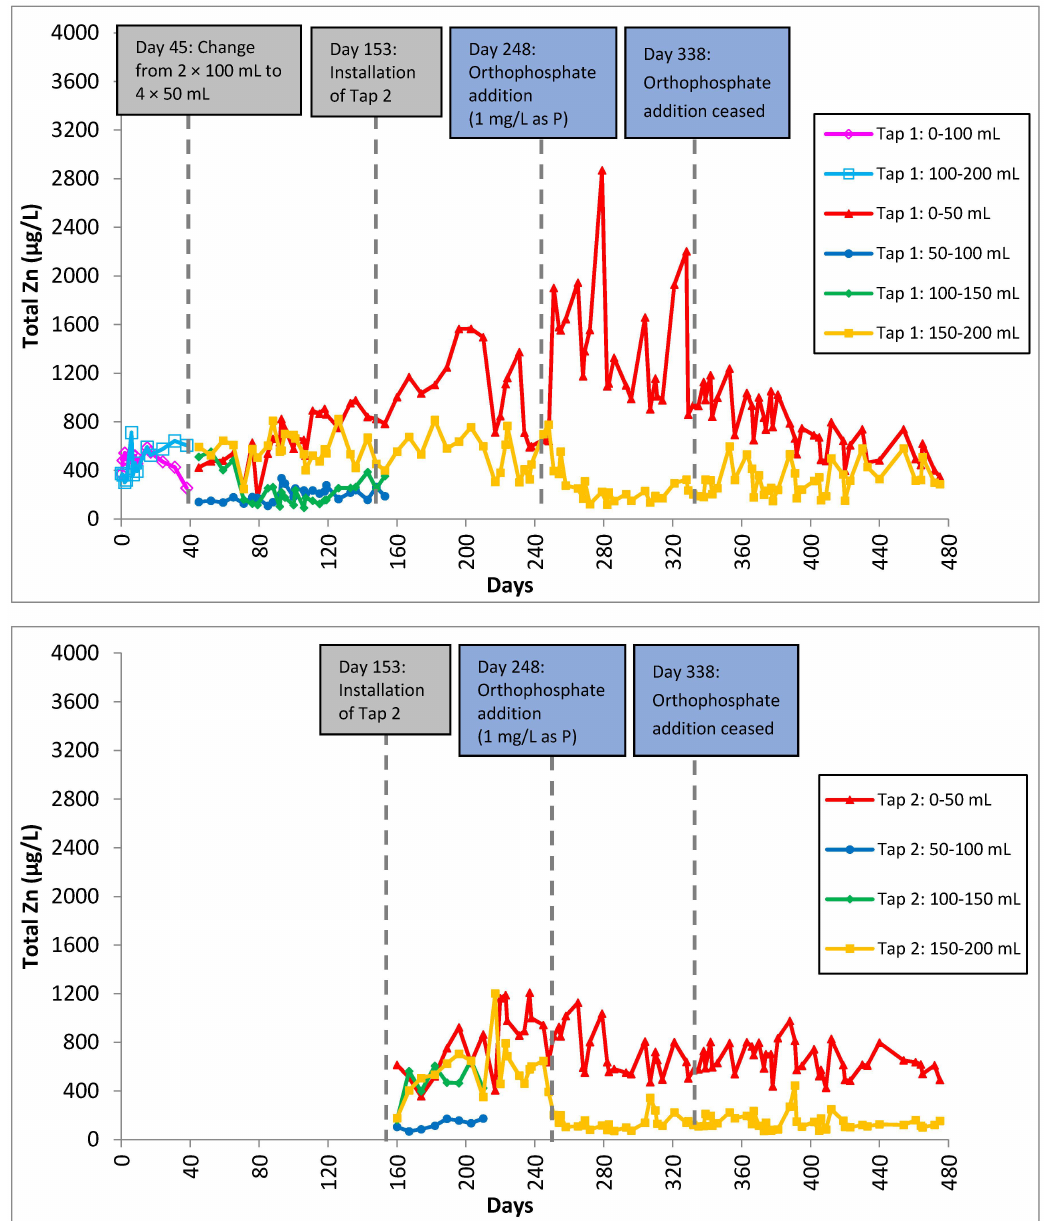
Figure 5. Total zinc in Tap 1 ( top ) and Tap 2 ( bottom ) samples as a function of time for 475 days. A second tap was installed on Day 153 and orthophosphate was introduced on Day 248 and discontinued on Day